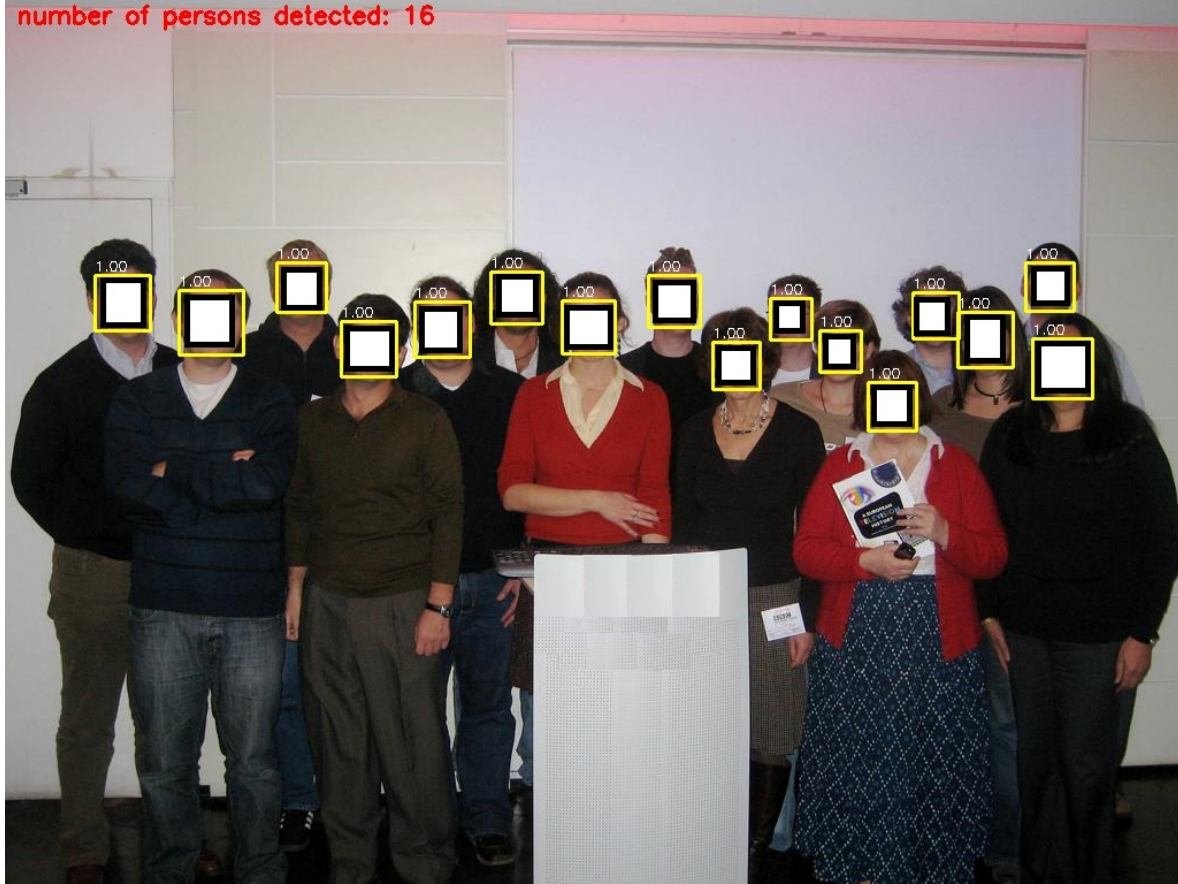
Figure 8. The output result of the proposed YOLOv3, which aimed to recognize a large number of persons (released from WIDER dataset [34]).